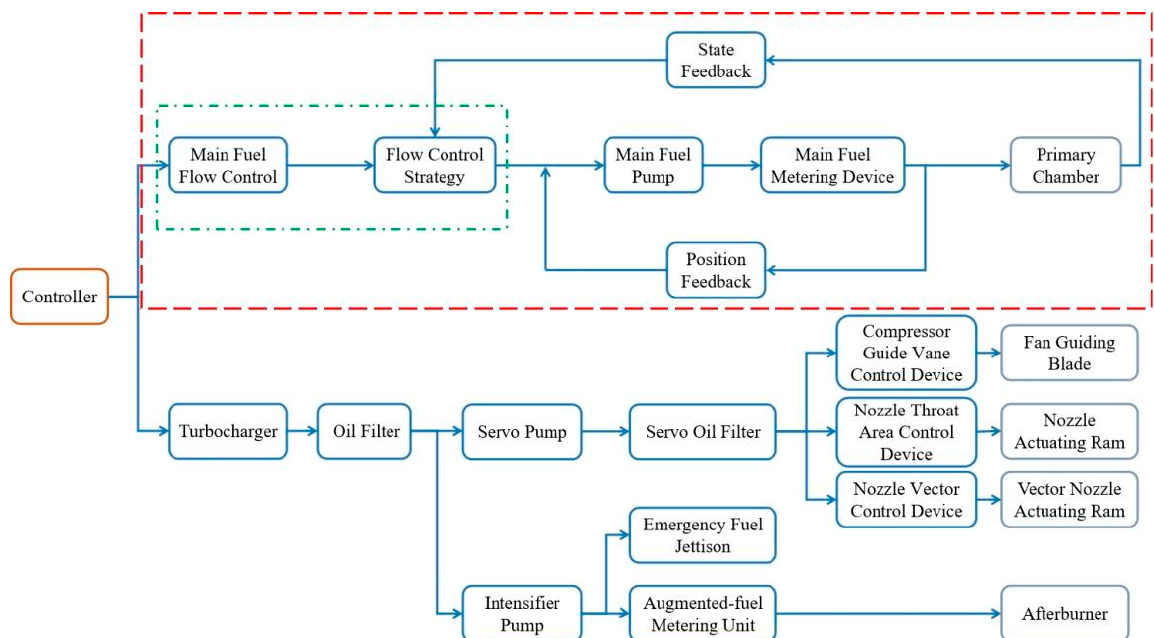
Figure 1. Aircraft engine electronic control system composition diagram.